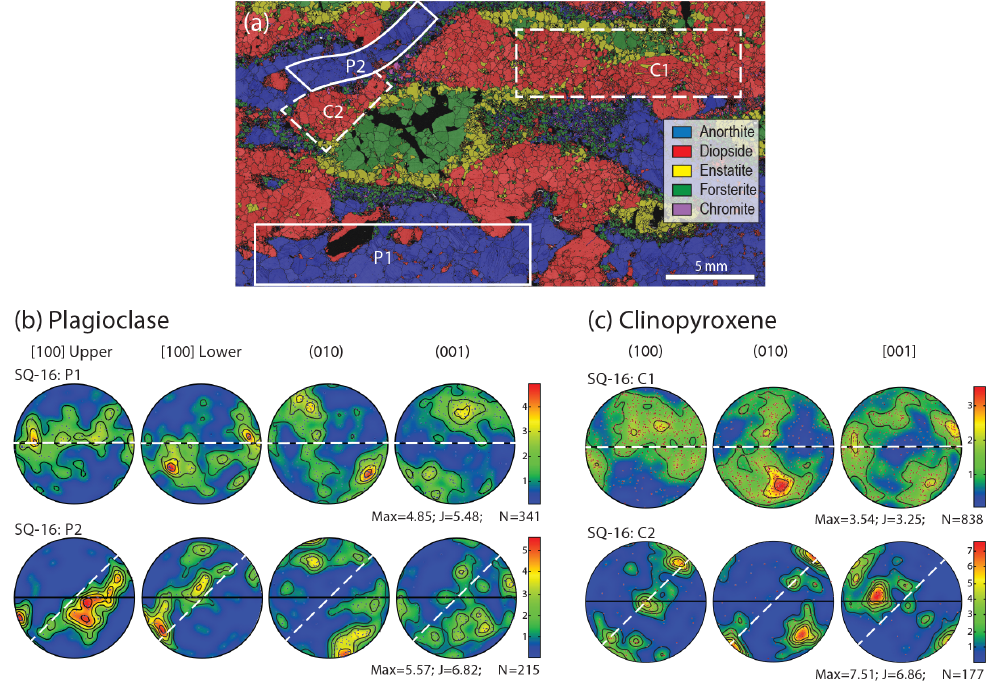
Figure 10. EBSD map and crystallographic orientations illustrating the control of the local flow field on plagioclase and clinopyroxene CPO. (a) Same EBSD map with Fig. 3a showing the location of the domains in which plagioclase and clinopyroxene domainal CPOs were analyzed. (b, c) Domainal plagioclase and clinopyroxene CPOs. Crystallographic orientations are plotted as one point per grain data set in lower-hemisphere equal-area projections, relative to the observed foliation and lineation. Color scales are for multiples of uniform distribution. For each sample, the J index and the number of grains analyzed are given. White dashed lines describe the local shear plane. In P2 and C2 the shear plane is subparallel to the zone of localized